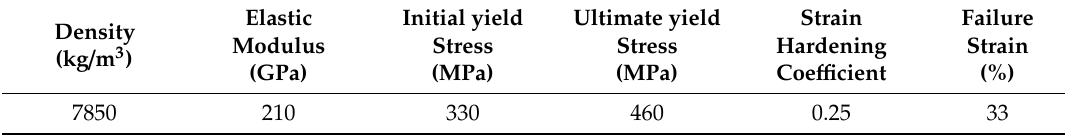
Table 2. Material properties of ST-52.